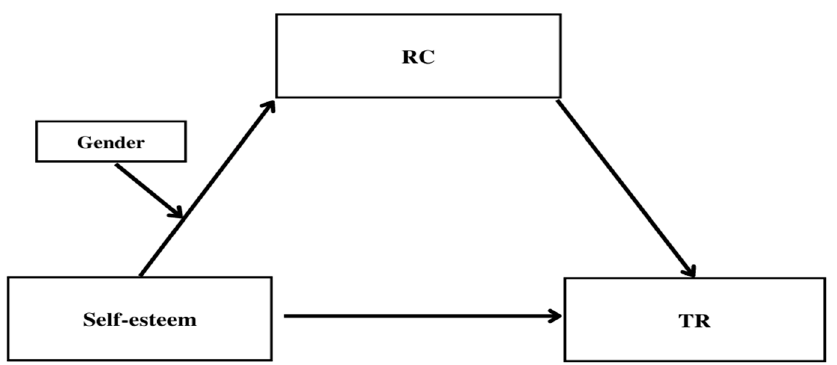
Figure 1. Research